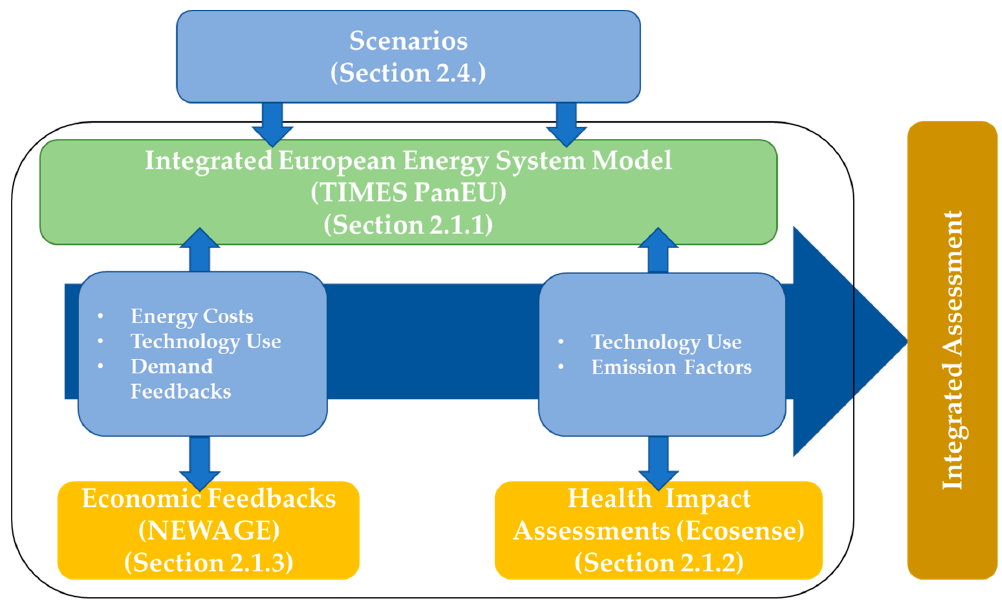
Figure 1. The Integrated Assessment Toolbox.